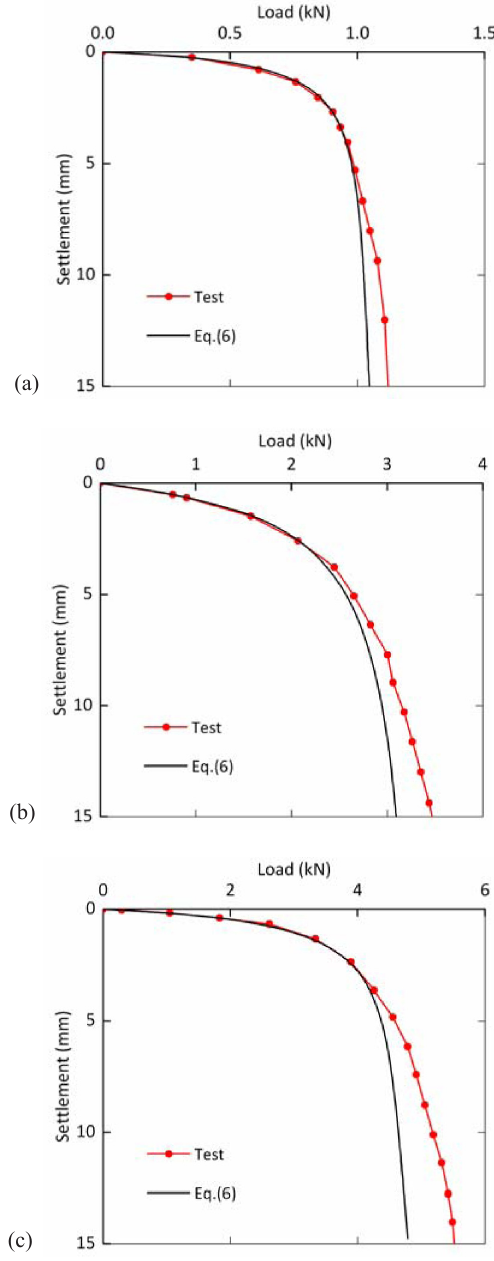
Fig. 10. Measured single pile axial load response and predicted from Eqn (6), ( S/B = 3): (a) loose sand, (b) medium dense sand, (c) dense